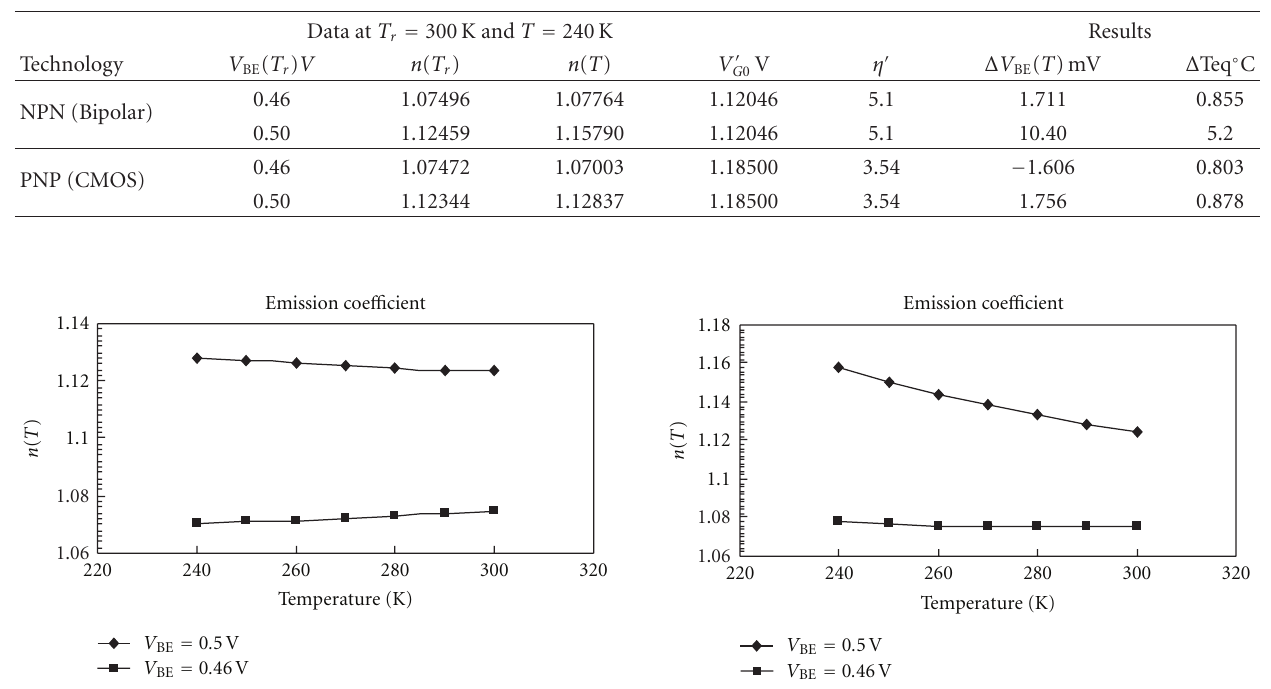
Table 2: Calculated values of Δ V BE and its equivalent temperature error.